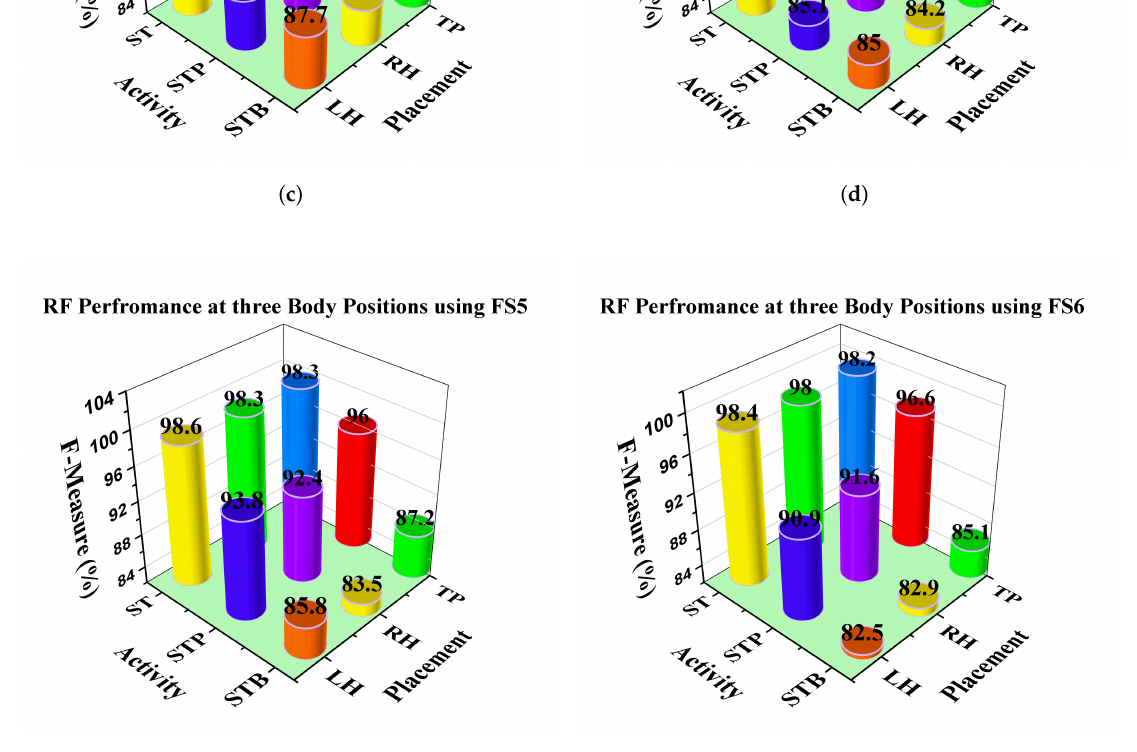
Figure 6. Performance of the RF classifier at different positions over the 12 s window size by using: ( a ) feature set 1; ( b ) feature set 2; ( c ) feature set 3; ( d ) feature set 4; ( e ) feature set 5; ( f ) feature set